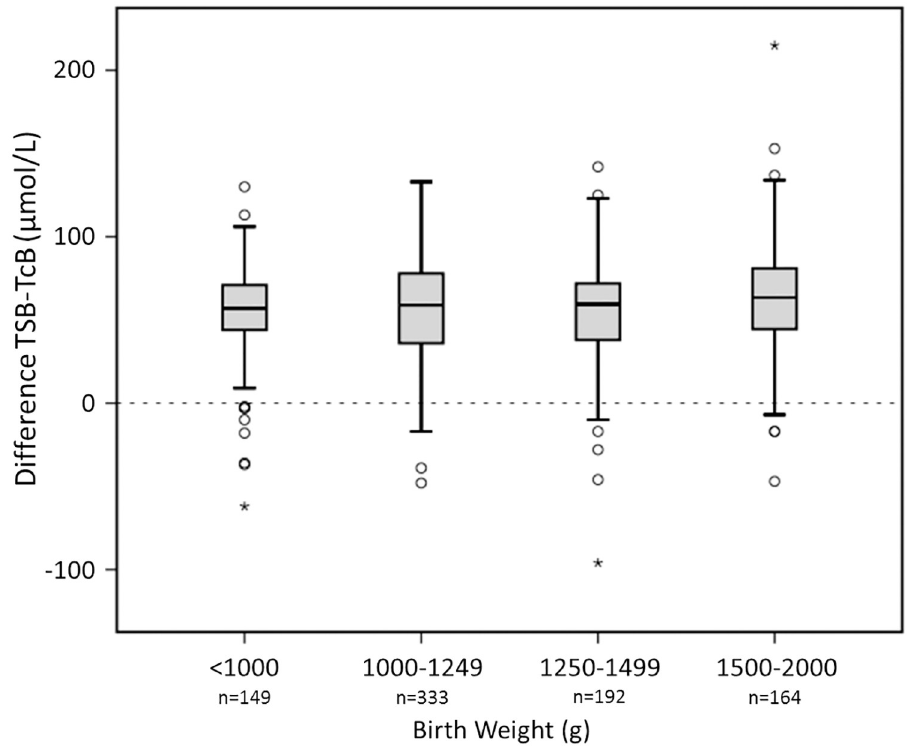
Fig 3. Birth weight categories and the mean difference between TSB and TcB. The y–axis displays the mean difference between TSB and TcB in μ mol/L. TSB, total serum bilirubin in μ mol/L; TcB, transcutaneous bilirubin in μ mol/L; 17.1 μ mol/L = 1 mg/dL bilirubin. The median is marked by the horizontal line in the central box. The boxes are limited by the 25th and 75th percentiles. The whiskers ( ┴ ) represent the minimum and maximum TSB and TcB levels. Outliers ( � ) and extremes (star symbol) are depicted separately. The dashed line is the line at origin.